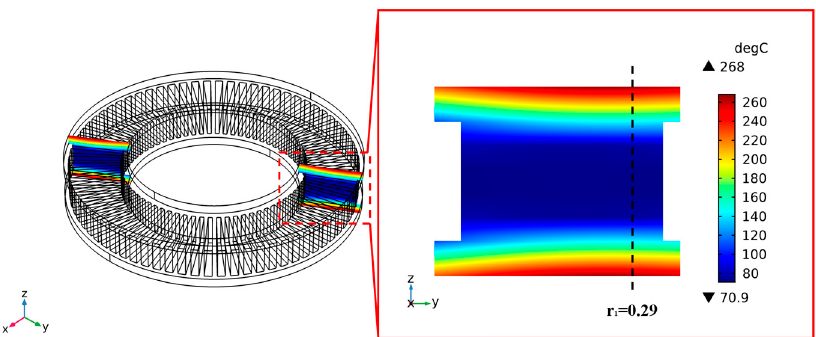
Figure 11. Temperature clouds in the axial section of the interstitial